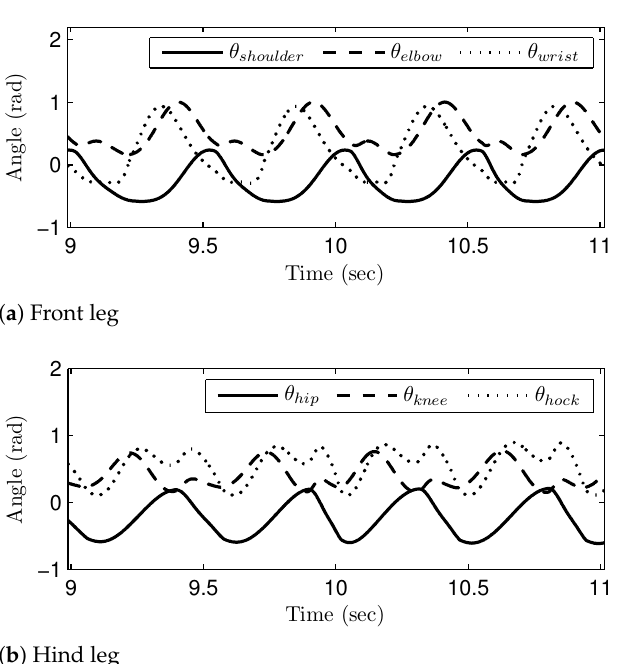
Figure 17. The join-angle trajectories when the gait phase is changed from the canter to transverse gallop: ( a ) front leg and ( b ) hind leg.